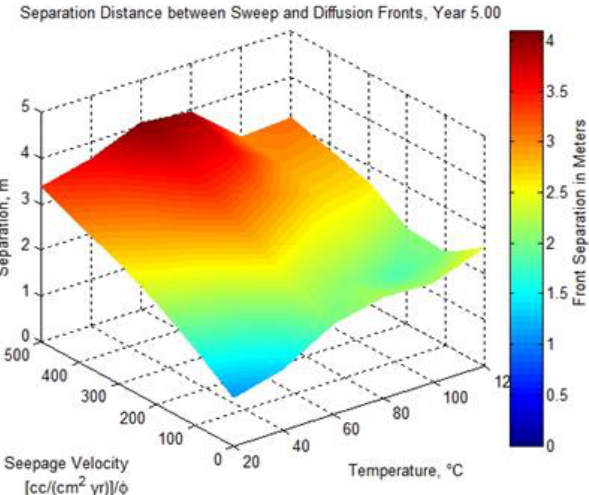
Figure 1. The separation distance between the low pH diffusion front and the high alkalinity sweep front as a function of seepage velocity, reservoir temperature, and time.